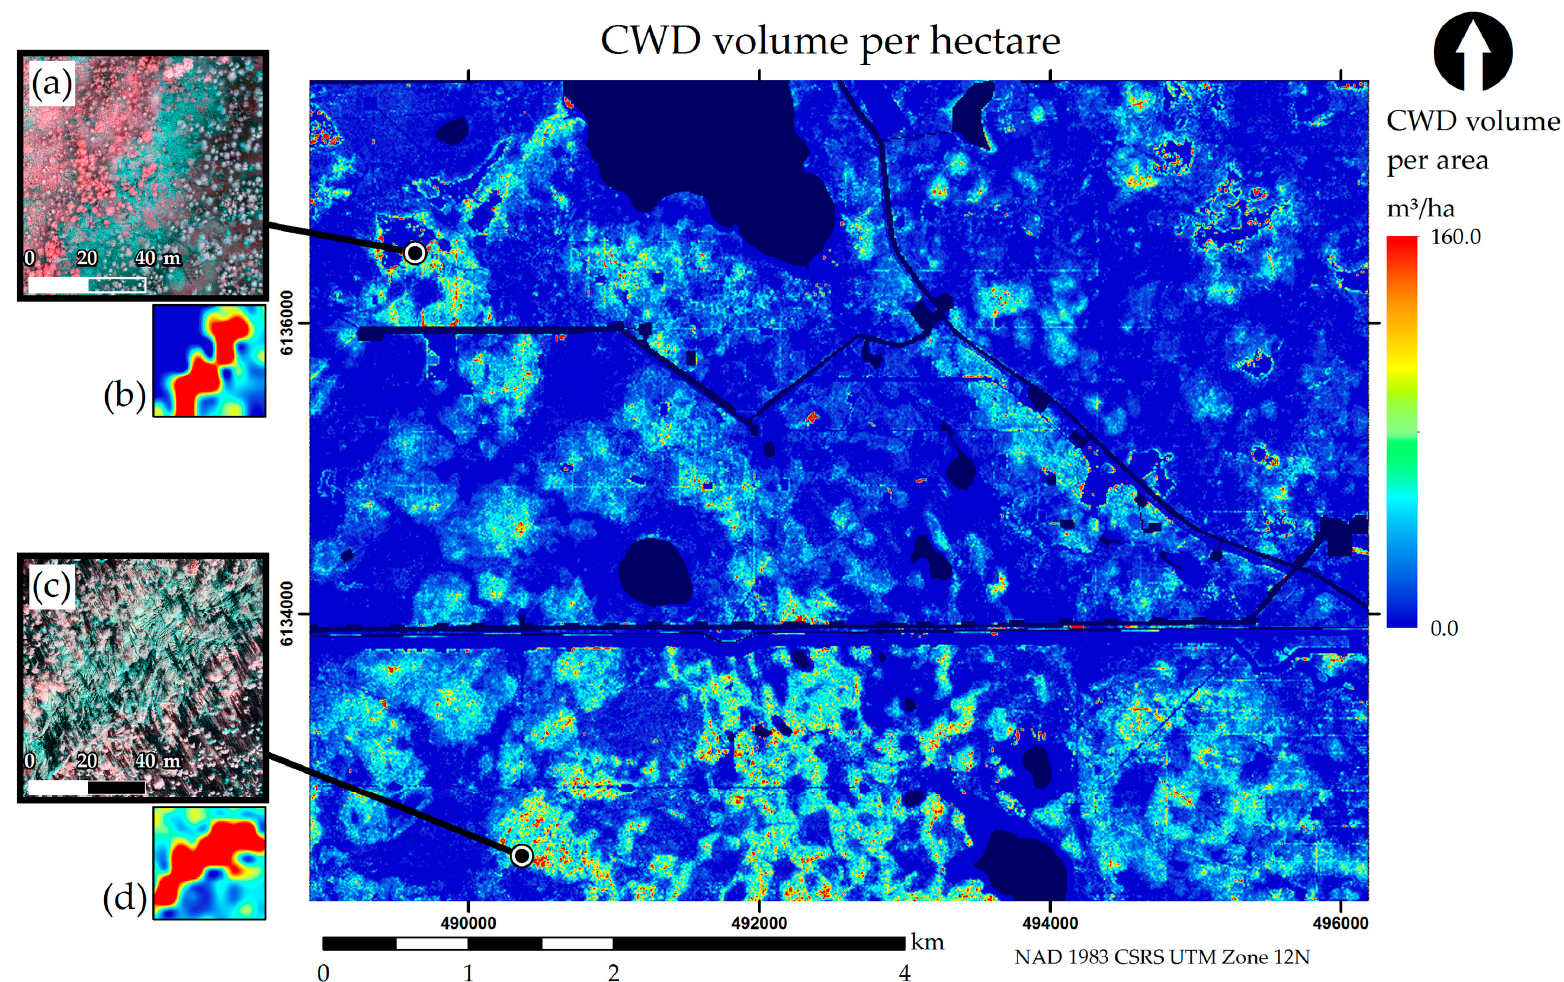
Figure 4. Map of coarse woody debris (CWD) volume per hectare (m 3 / ha) over the study area. High quantities of CWD are displayed in red, medium quantities in yellow and low quantities in blue. Roads and water bodies are excluded from the CWD volume model and are presented as dark blue. Insets ( a ) and ( c ) showcase hotspots of CWD in false-color imagery. Insets ( b ) and ( d ) showcase the CWD volume map over ( a ) and ( c )